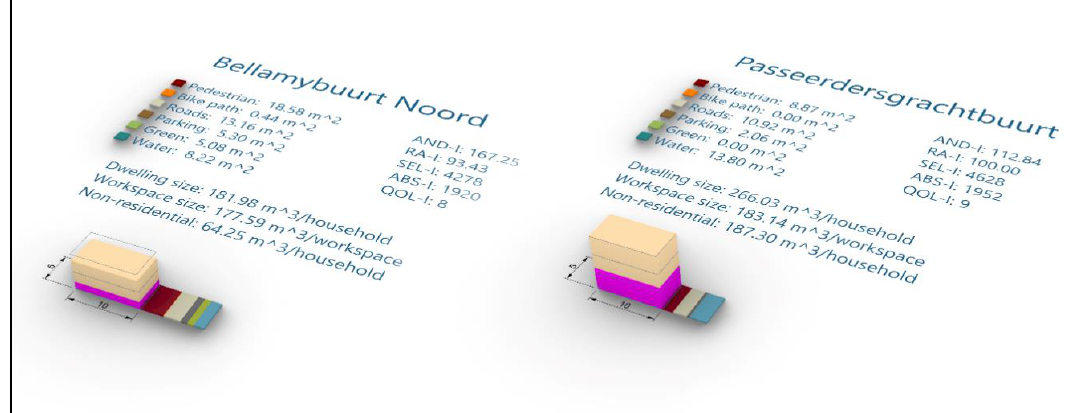
Figure 16. Example of two prototypic buildings used for comparison. Each building represents the living-space values of the corresponding neighborhood (e.g., Bellamybuurt Noord and Passeerdersgrachtbuurt).